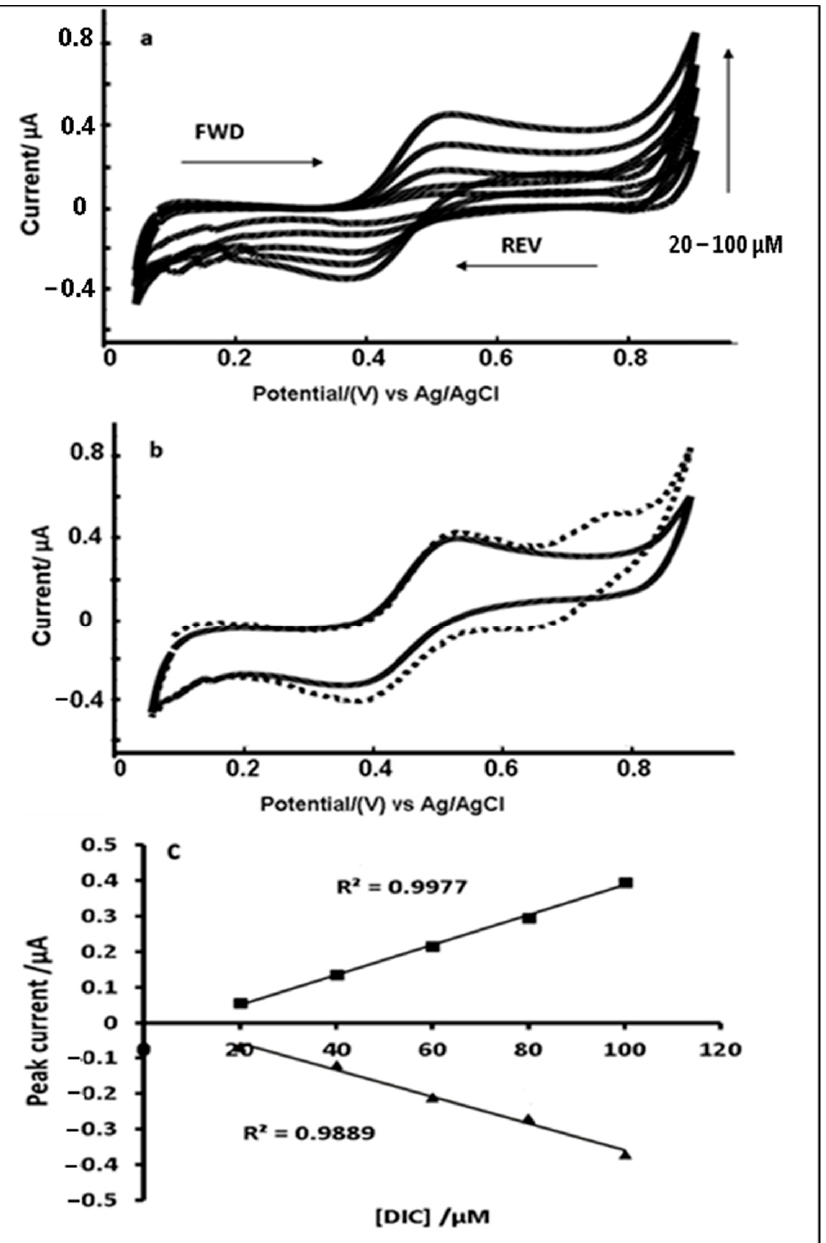
Figure 3. ( a ) Background-subtracted voltammograms of DIC + transfer in the concentrations range of 20 to 100 µ M, in increment of 20 µ M. ( b ) Voltammograms of 100 µ M DIC + with 40 µ M TMA + (dashed line) across water|1,6-DCH microinterface at scan rate 10 mVs − 1 . ( c ) Calibration curve of the forward peak currents (positive scan) and reverse peak currents (negative scan) against DIC + concentrations.